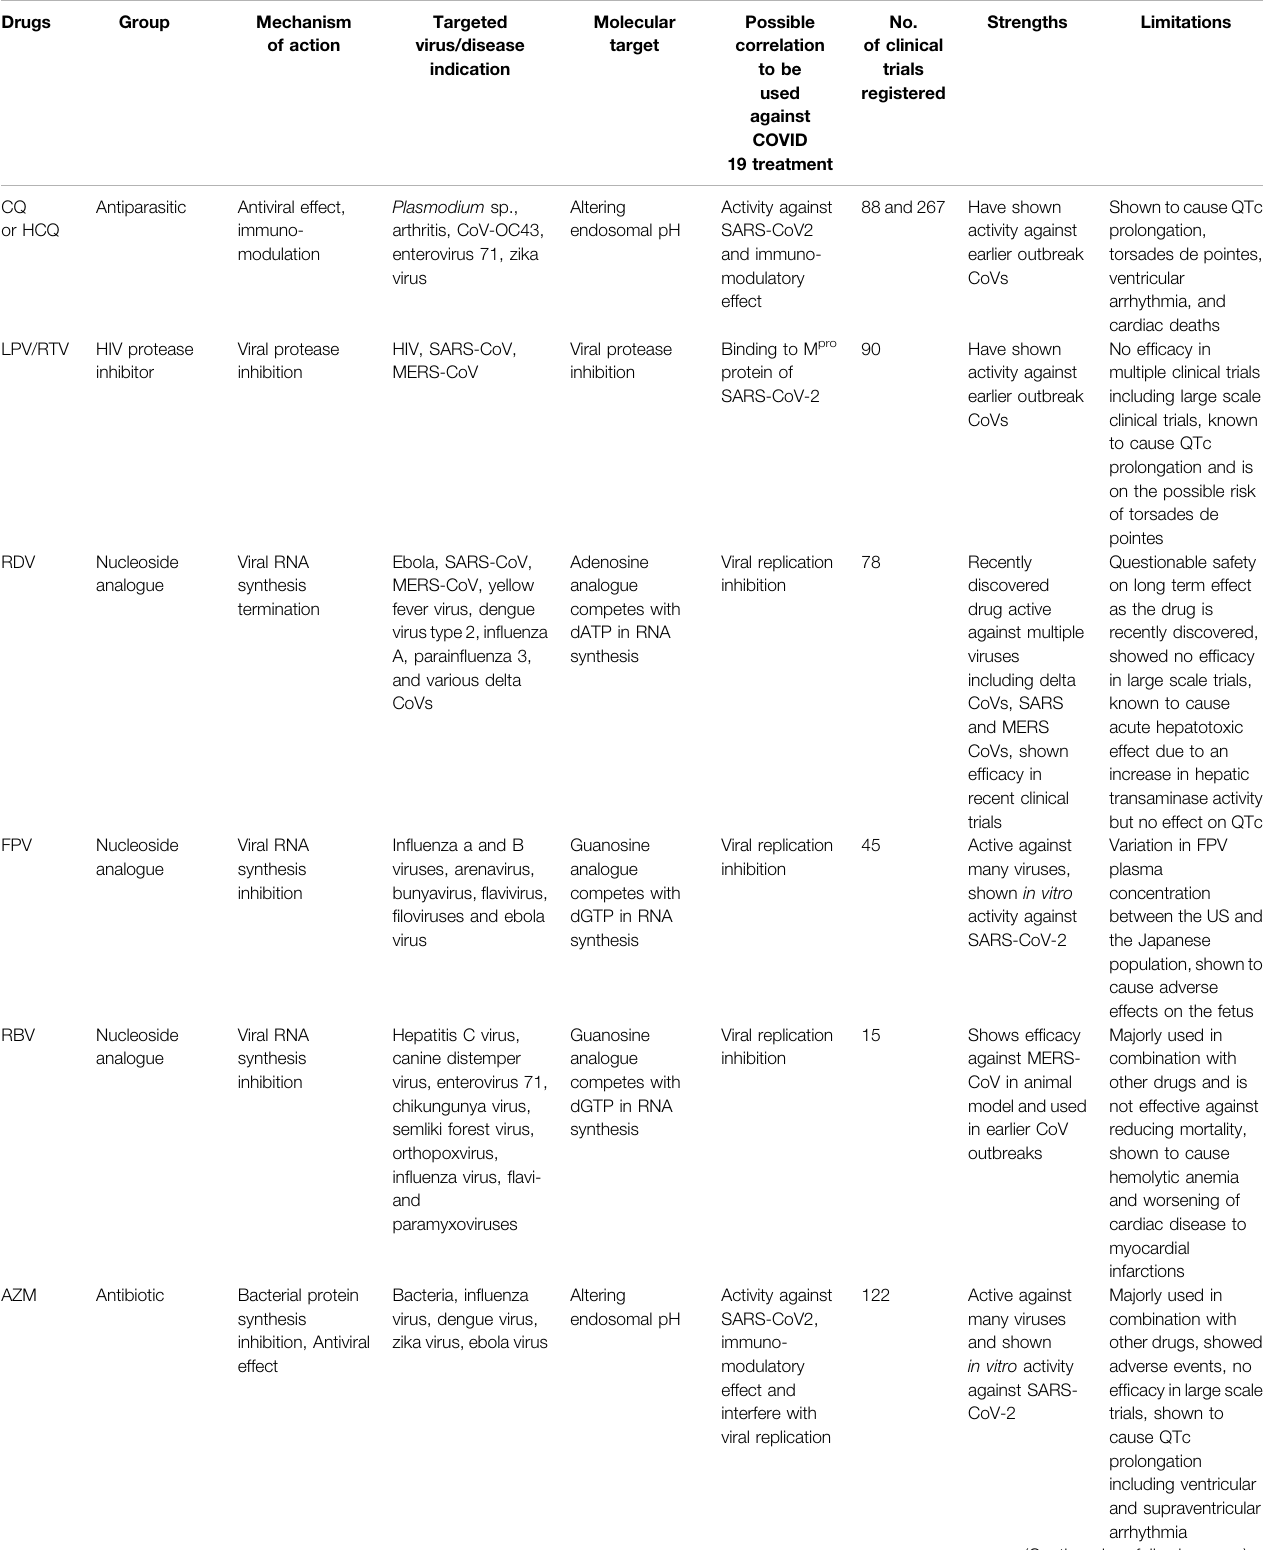
TABLE 1 | General information of repurposed drugs used against